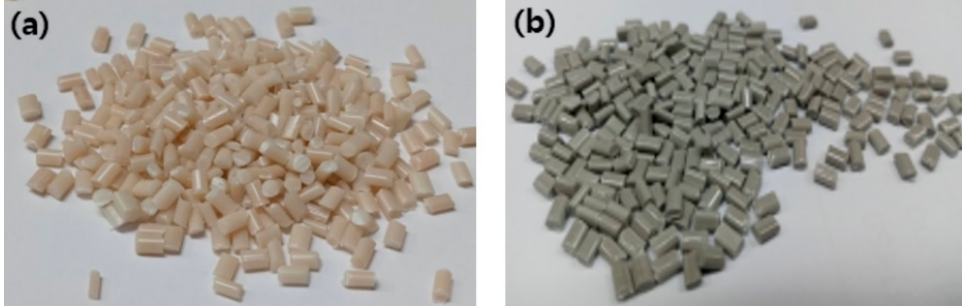
Figure 1. Polymer masterbatches for shielding fiber: ( a ) barium sulfate (50 wt%) masterbatch and ( b ) bismuth oxide (20 wt%) masterbatch.